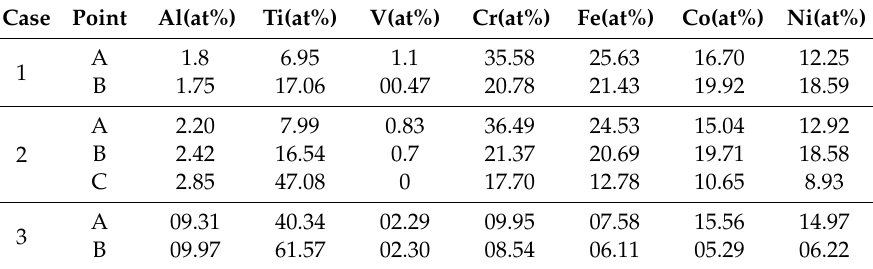
Figure 7. SEM images of laser cladded coatings in different region. ( a ) Case 1, ( b ) Case 2, ( c ) Case 3. Table 4. The chemical composition of different points in Figure 7.